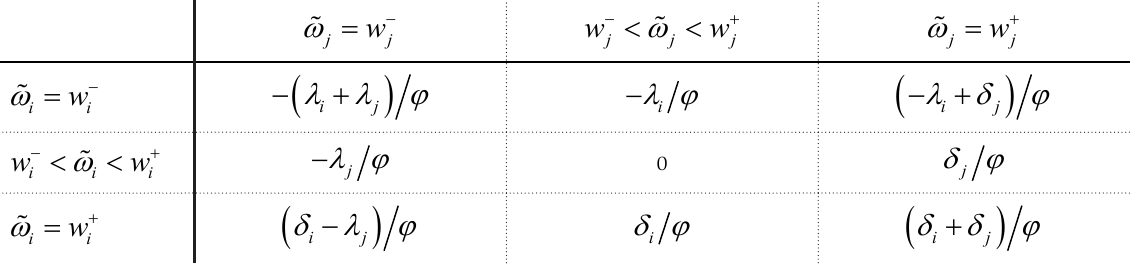
Table 1. Elements of the perturbation matrix,